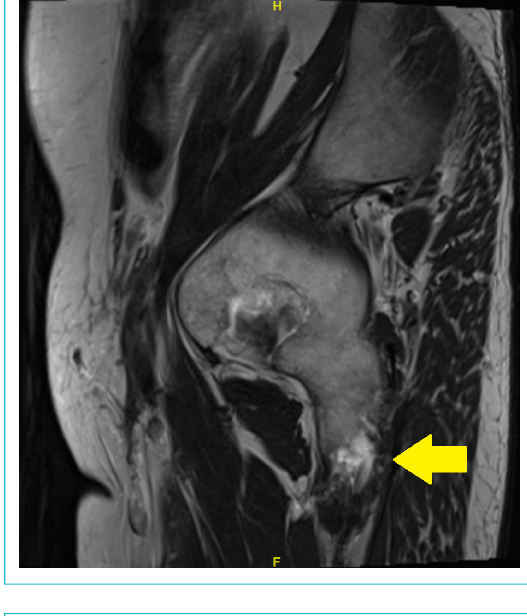
Figure 3: MRI of the pelvis with T2 turbo spin echo (TSE) images: sagittal view. Arrow: partial avulsion on the right side.